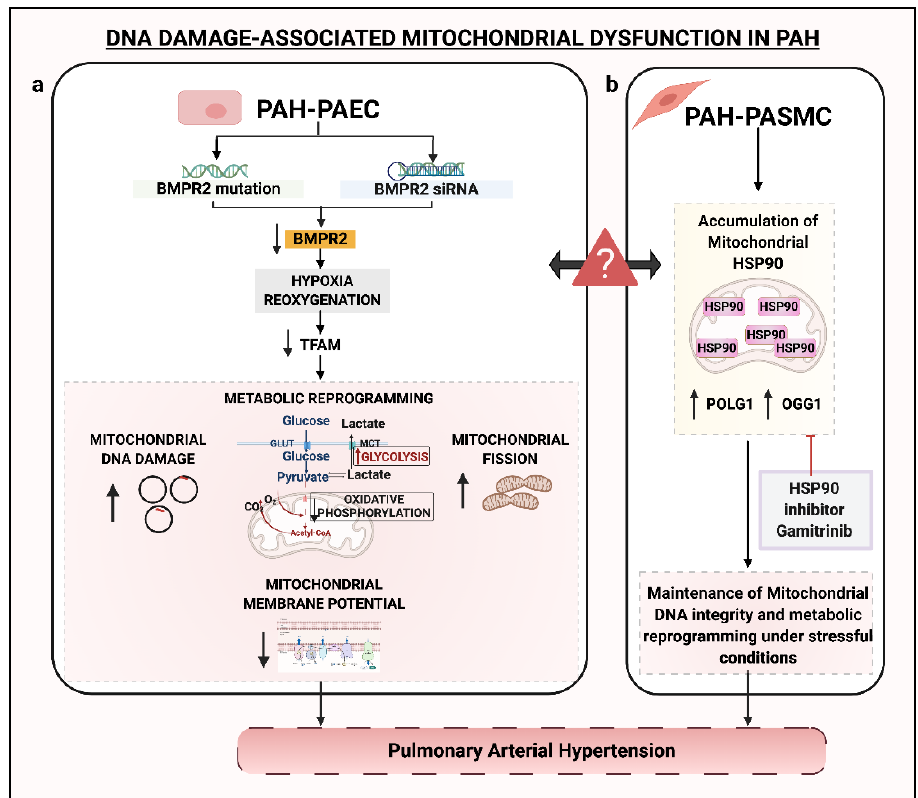
Figure 4. DNA damage-associated mitochondrial dysfunction in ( a ) PAH-PAEC and ( b ) PAH-PASMC. ( a ) In PAH-PAECs, reduced expression of BMPR2 accompanied by hypoxia-reoxygenation is associated with reduced expression of the mitochondrial DNA maintenance gene, TFAM, increased mitochondrial DNA damage, and decreased mitochondrial membrane potential. These factors, associated with reduced oxidative phosphorylation and increased glycolysis, trigger endothelial dysfunction in PAH-PAECs [78]. ( b ) In PAH-PASMCs, increased mitochondrial HSP90 accumulation along with an increased expression of POLG1 and OGG1 is proposed as a regulatory mechanism in the maintenance of mitochondrial DNA and metabolic reprogramming under stressful conditions [88]. The question mark symbol between the two cell types indicates a lack of studies showing crosstalk between the two cell types. DNA, Deoxyribonucleic acid; TFAM, Transcription Factor A Mitochondrial; GLUT, Glucose transporter; MCT, monocarboxylate transporter; O 2 , Oxygen; CO 2 , Carbon dioxide; HSP90, Heat shock protein 90; POLG1, Mitochondrial DNA polymerase γ; OGG1, 8-Oxoguanine glycosylase. Created with BioRender.com.